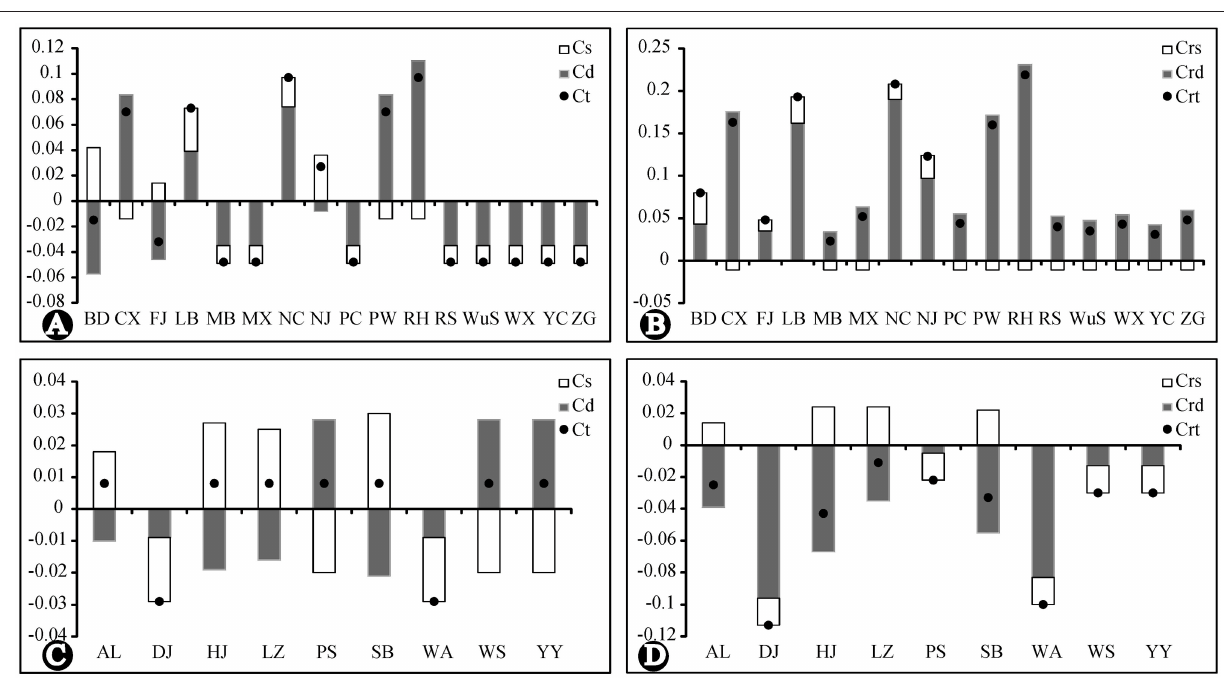
(Zhu et al., 2015). In our study, R. chinensis var. spontanea and R. lucidissma shared one cpDNA haplotype and three